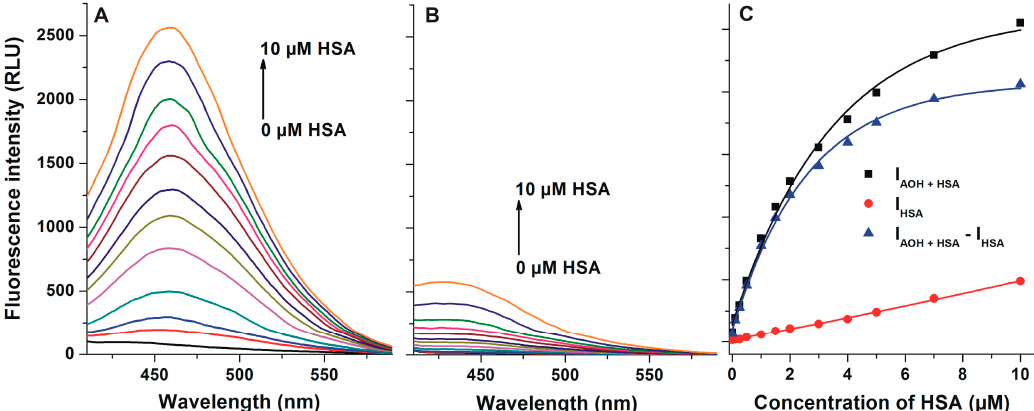
Figure 3. ( A ) Fluorescence emission spectrum of AOH (1 μ M) in the presence of increasing human serum albumin (HSA) concentrations (0.0, 0.1, 0.25, 0.5, 1.0, 1.5, 2.0, 3.0, 4.0, 5.0, 7.0, and 10.0 μ M) in PBS (pH 7.4); ( B ) Fluorescence emission spectrum of increasing concentrations of HSA (0.0, 0.1, 0.25, 0.5, 1.0, 1.5, 2.0, 3.0, 4.0, 5.0, 7.0, and 10.0 μ M) in PBS; ( C ) Fluorescence emission intensity of AOH in